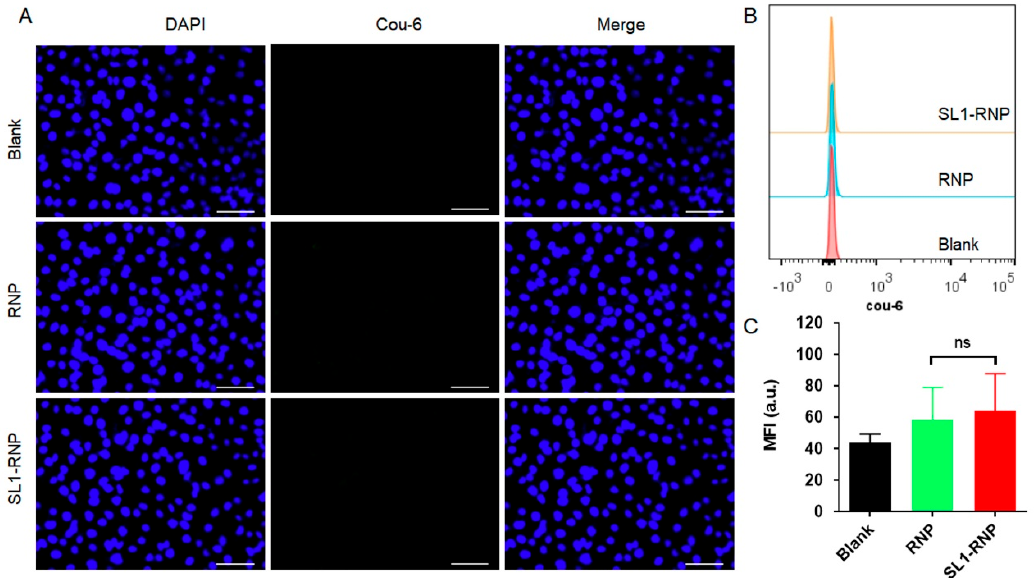
Figure 4. Cellular uptake of Coumarin 6 − labelled SL1 − RNP by HUVECs. ( A ) Fluorescence images of HUVECs treated with Coumarin 6 − labelled RNP and SL1 − RNP for 1 h, respectively (scale bar = 100 μ m). ( B ) Representative flow cytometry histograms and ( C ) the corresponding fluorescence in- tensity of HUVECs treated with Coumarin 6 − labelled RNP and SL1 − RNP for 1 h ( n = 3). Cou − 6, Coumarin − 6. MFI, mean fluorescence intensity. ns indicated no significance.